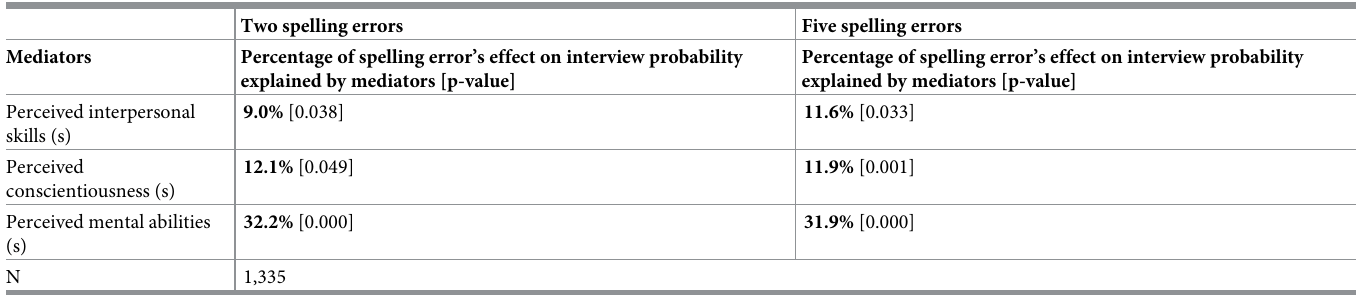
Table 5. Mediation analysis: Percentages of spelling error’s effects on interview probability explained by each mediating scale. Two spelling